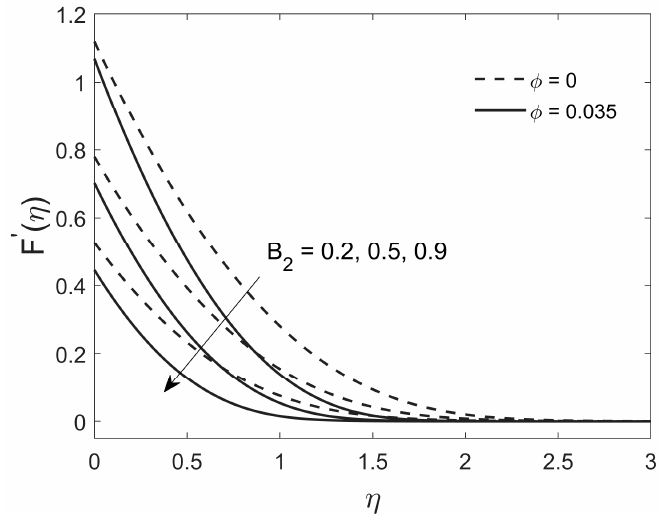
Figure 3. Effect of a partial slip on the velocity profile.